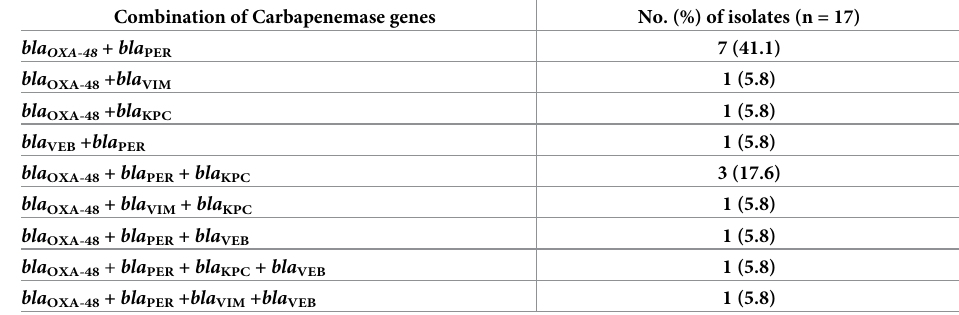
Table 8. Coproduction of carbapenemase genes by B2 E . coli isolates from outpatients with acute UTI.